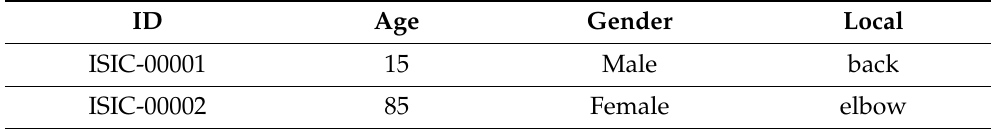
Table 3. Metadata example in the data